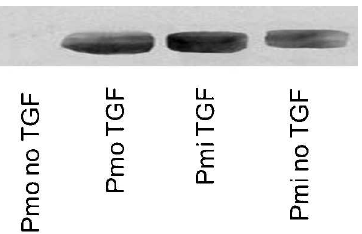
Figure 4 - The expression of type II collagen in the culture was greater in cells that were treated with TGF- b 3 than in cells cultured without TGF- b 3. Micromass cultures without TGF- b 3 also exhibited greater type II collagen expression compared to the monolayer cultures with TGF- b 3, corroborating the real-time PCR results. The cells that were grown in the monolayer without